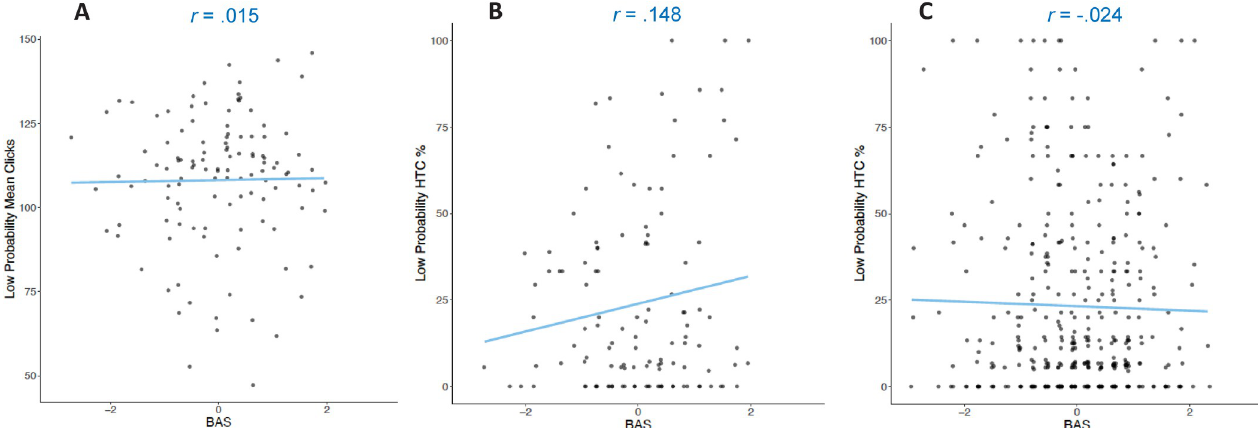
Fig 6. Pearson correlations between trait BAS scores (z-standardized) and task performance (Study 1 and 2). Correlations for the mean number of clicks within trials with low probability of reward attainment in the modified EEfRT ( A: Study 1) and percentage of hard task choices within trials with low probability of reward attainment in the original EEfRT ( B : Study 1; C: Study 2). All depicted correlations were nonsignificant with p > .05.